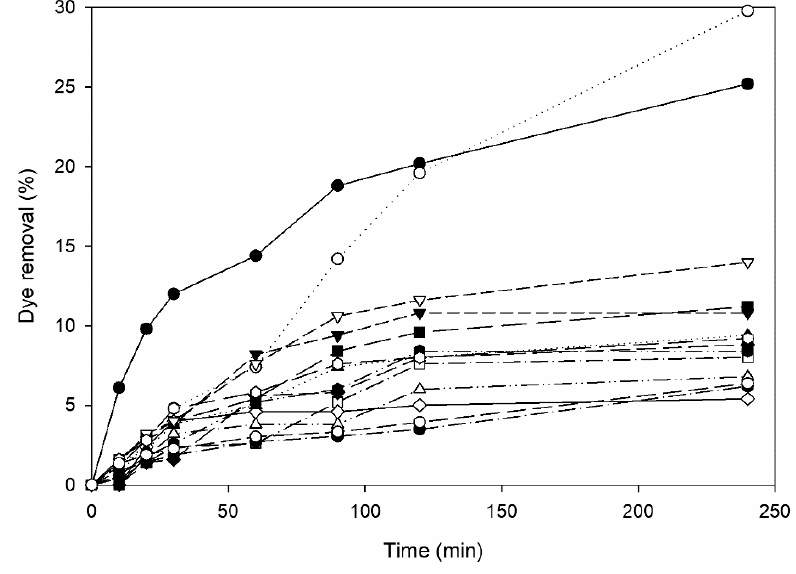
... ... ); Figure 8. Percentage of CR removal at different pH for pH3 L1 (-●-); pH3 L2 ( … ○ … ); pH4 L1 (-- (cid:35)